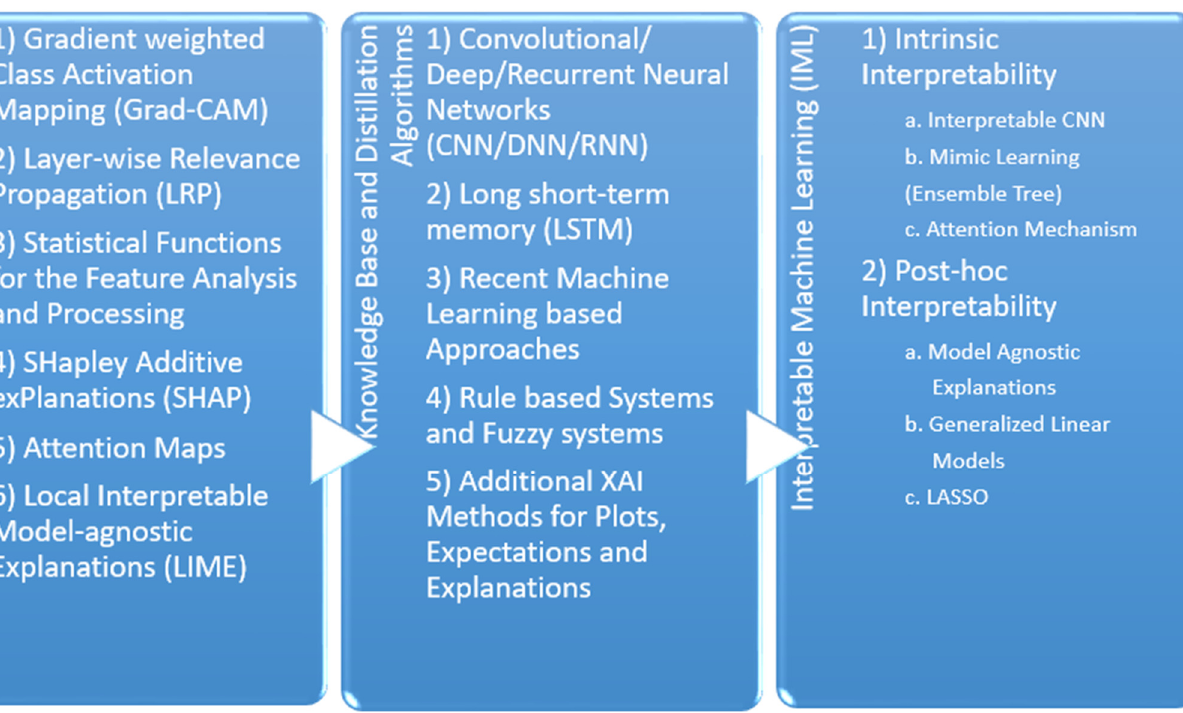
Figure 3. XAI Methods